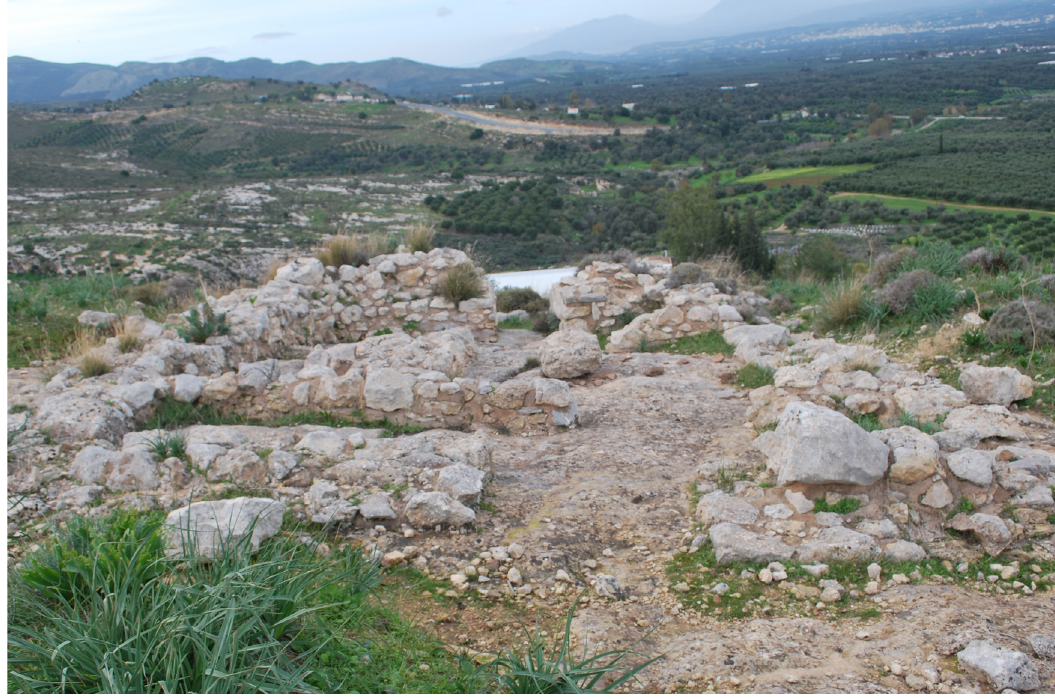
Figure 6. The annex rooms of Tholos A, seen from the east. The circular chamber is located to the west, at a lower level of the